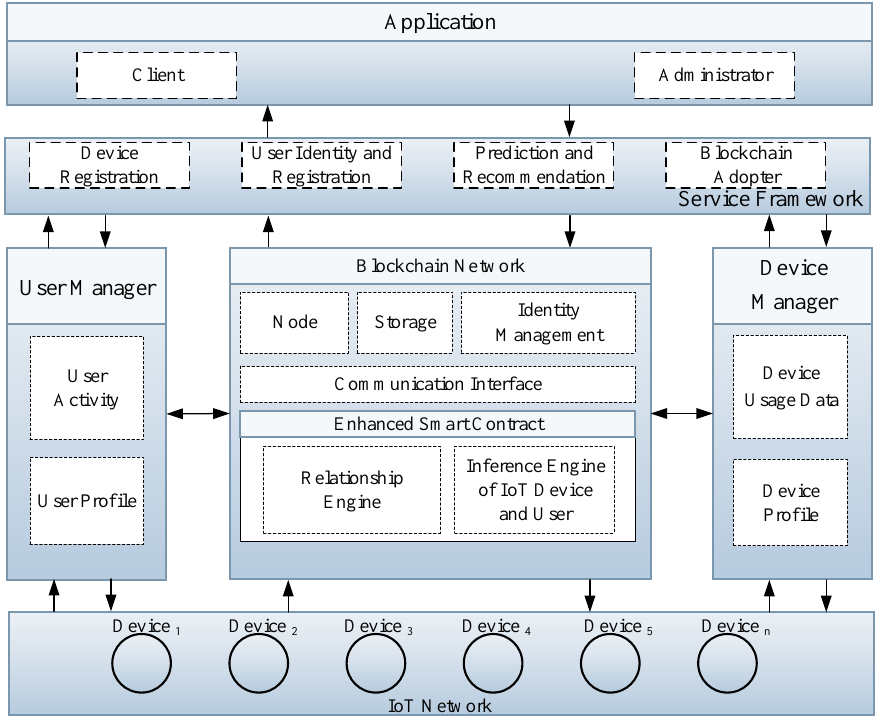
Figure 1. Proposed intelligent service model based on enhanced smart contract with relationship and inference engine in IoT network.